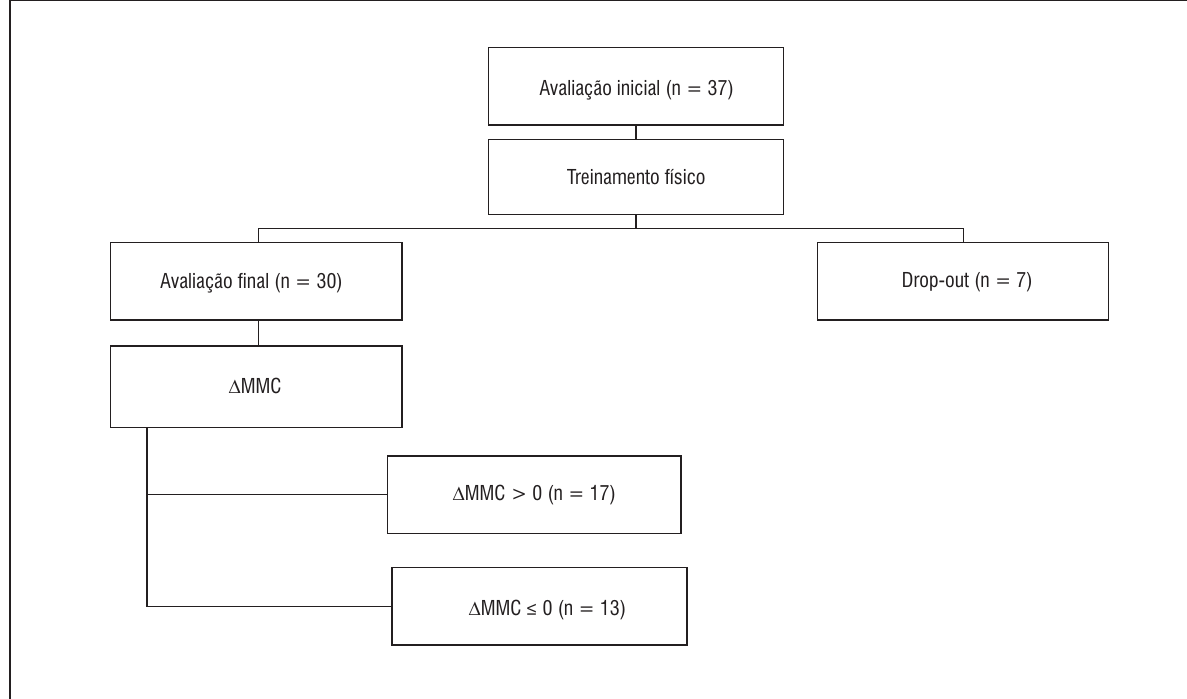
Figura 1 - Fluxograma de pacientes recrutados para o estudo